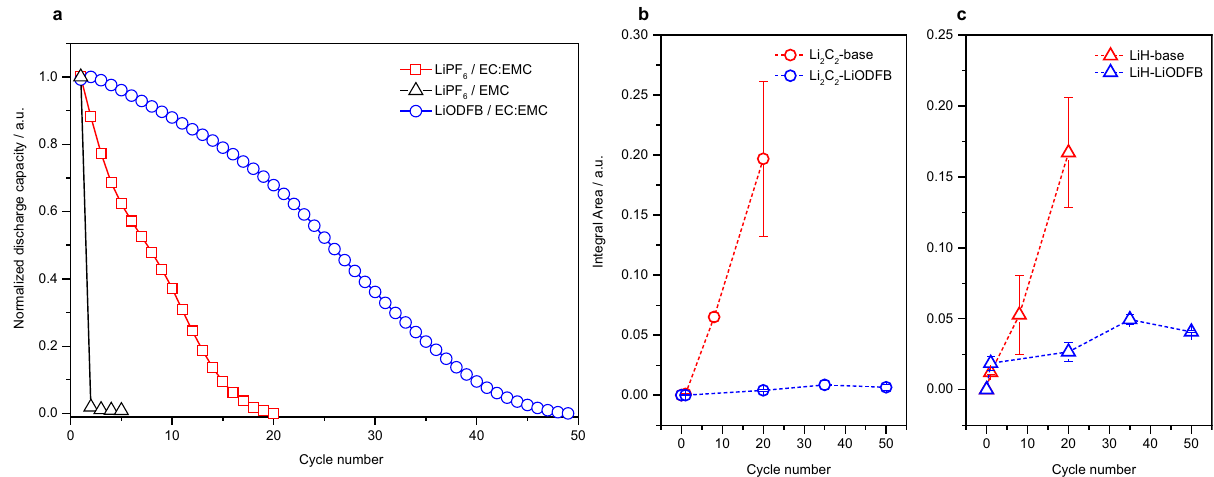
Fig. 4 | Suppressing LiH and Li 2 C 2 by electrolyte optimization. a The cycle performanceofCu||LiFePO 4 cells,whichcycledbetween2.8Vand3.8Vwitha fi xed current density of 0.75mAcm − 2 using 1M LiPF 6 /EMC, 1M LiPF 6 /EC:EMC (baseline)